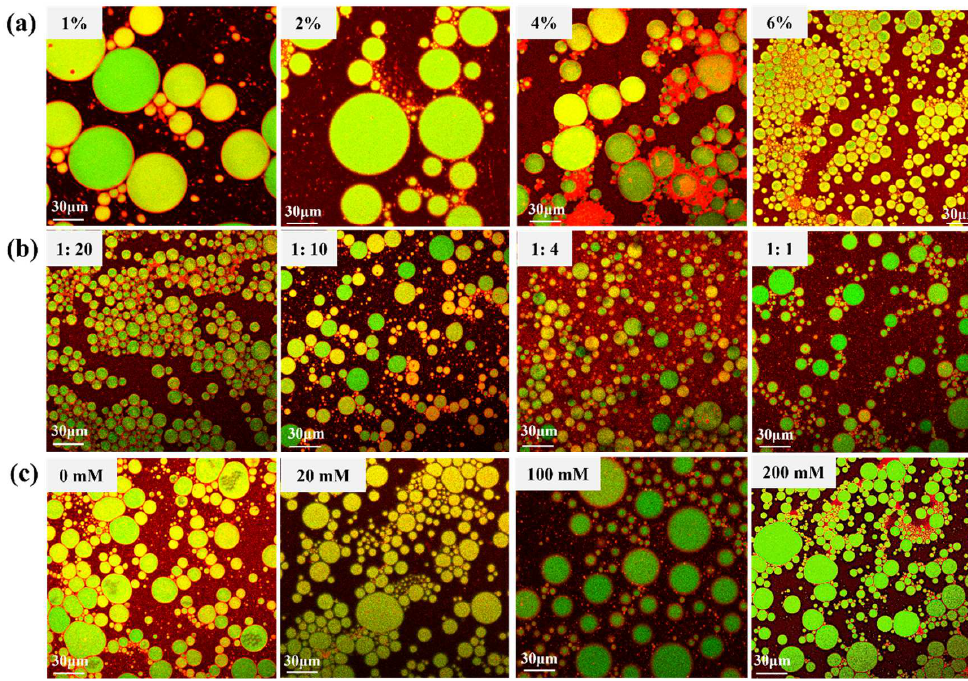
Figure 6. CLSM images of OS/β-lg complex stabilized emulsions at different particle concentrations ( a ), oil/water fractions ( b ), and ionic strengths ( c ). Scale bars are 30 μm.